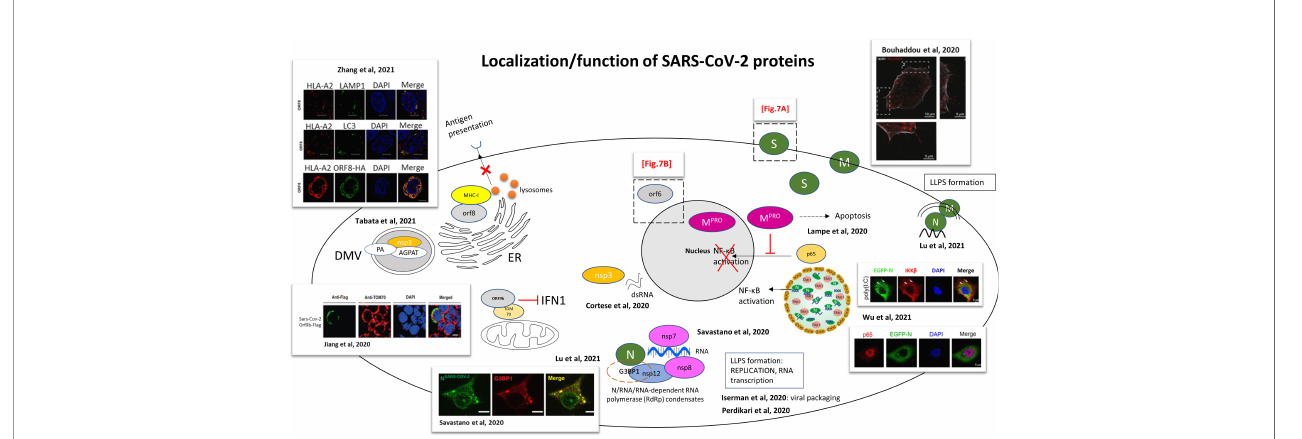
FIGURE 6 | Functional studies for the localization and functions of SARS-CoV-2 proteins. Schematic representation of an infected cell and the localizations/functions of the different SARS-CoV-2 proteins. The drawings are based on the articles indicated in the fi gure. Dashed boxes: detailed regions in Figures 7A , B S: spike protein; M: membrane protein; N: nucleocapsid. M protein was encountered localizing with actin fi laments (Bouhaddou et al., 2020). SARS-CoV-2 infected Caco-2 cells immunostained for F-actin (white) and M protein (red). M protein localizes along and to the tip of fi lopodia. 1 and 2, dashed box: magni fi cation seen in pictures 1 and 2. Scale bar 10 µm; 5 µm in 1 and 2. SARS-CoV-2 main protease (Mpro) fused to HA tag (Mpro-HA) inhibits the nuclear translocation of the NF- k B subunit p65, blocking NF- k B activation (by abolition of NF-kB mediated gene transcription by IL-1 b ) (Wenzel et al., 2021). LLPS of SARS-CoV-2 N protein recruits TGF-beta- activated kinase 1 (TAK1) and I k B kinase (IKK) complex. Schematic representation from Wu et al. of SARS-CoV-2 N protein regulating NF- k B signaling pathway by recruiting TAK1 and IKK b through liquid – liquid phase separation. Confocal picture: Huh7 cells stably expressing EGFP-N protein, treated with 1 m g/mL poly(I:C) for 6 h, followed by labelling IKK b and DAPI. Scale bars, 5 m m (Wu et al., 2021b). Nucleocapsid protein LLPS concentrates SARS-CoV-2 replication machinery components: RNA-dependent RNA polymerase, non-structural protein nsp12, accessory sub-units nsp7 and nsp8 (required for transcription) concentrate with RNA/ N droplets. Confocal picture: SARS-CoV-2 Nucleocapsid protein associates with stress granules, formed through LLPS to maximize replication ef fi ciency. Colocalization of Alexa Fluor 488 labeled N-SARS-CoV-2 (green) with stress granule marker G3BP1 (red) in arsenite-treated digitonin-permeabilized HeLa cells. Scale bar: 10 µm (Savastano et al., 2020). N protein compacts viral RNA via protein-RNA LLPS, and interactions between N protein and host RNA-binding proteins are mediated by phase separation (Perdikari et al., 2020). SARS-CoV-2 N-protein undergoes liquid-liquid phase separation (LLPS) with the viral genome, and a model of viral packaging through LLPS is proposed (Iserman et al., 2020). SARS-CoV-2 double-stranded RNA, marker of viral replication, colocalizes with the viral protein nsp3 in the perinuclear region (Cortese et al., 2020). ORF9b colocalizes with mitochondrial TOM70 and blocks IFN1 production. Picture: Confocal microscopy of HEK 293T cells transfected by SARS-CoV-2 ORF9b-Flag. Staining with an anti- fl ag antibody (green) and an anti-TOM70 antibody (red). DAPI (blue): nuclei. Scale bar, 10 µm (Jiang et al., 2020). (Tabata et al., 2021): Confocal microscopy was used to show relocalization of AGPAT proteins to SARS-CoV-2 induced DMVs, colocalization of nsp3 (HA-nsp3) with PA (Phosphatidic acid) (GFP-PA) and AGPAT (acylglycerolphosphate acyltransferase) (GFP-AGPAT). CLEM was used to show formation of numerous DMVs. (Transient transfection of Huh7 cells with SARS-CoV-2 HA-nsp3-4-V5 expression construct and EGFP-PABD-Raf1-WT construct; or transfection with AGPAT2-GFP expressing plasmid and HA-nsp3-4-V5 expression construct). SARS-CoV-2 ORF8-HA co-localizes with MHC-I (HLA-A2), mediating MHC-I downregulation via degradation. Confocal picture: co-localization of HLA-A2 (red) with LAMP1 (green) lysosomes, with LC3 (green) (marker of autophagosomes) and with SARS-CoV-2 ORF8-HA (green). Scale bars, 5 m m. HEK293T cells were transfected with ORF8-HA expressing plasmid (Zhang et al., 2021b). SARS-CoV-2 N protein forms condensates with viral RNA and membrane associated M protein for packaging of the viral RNA (Lu et al.,